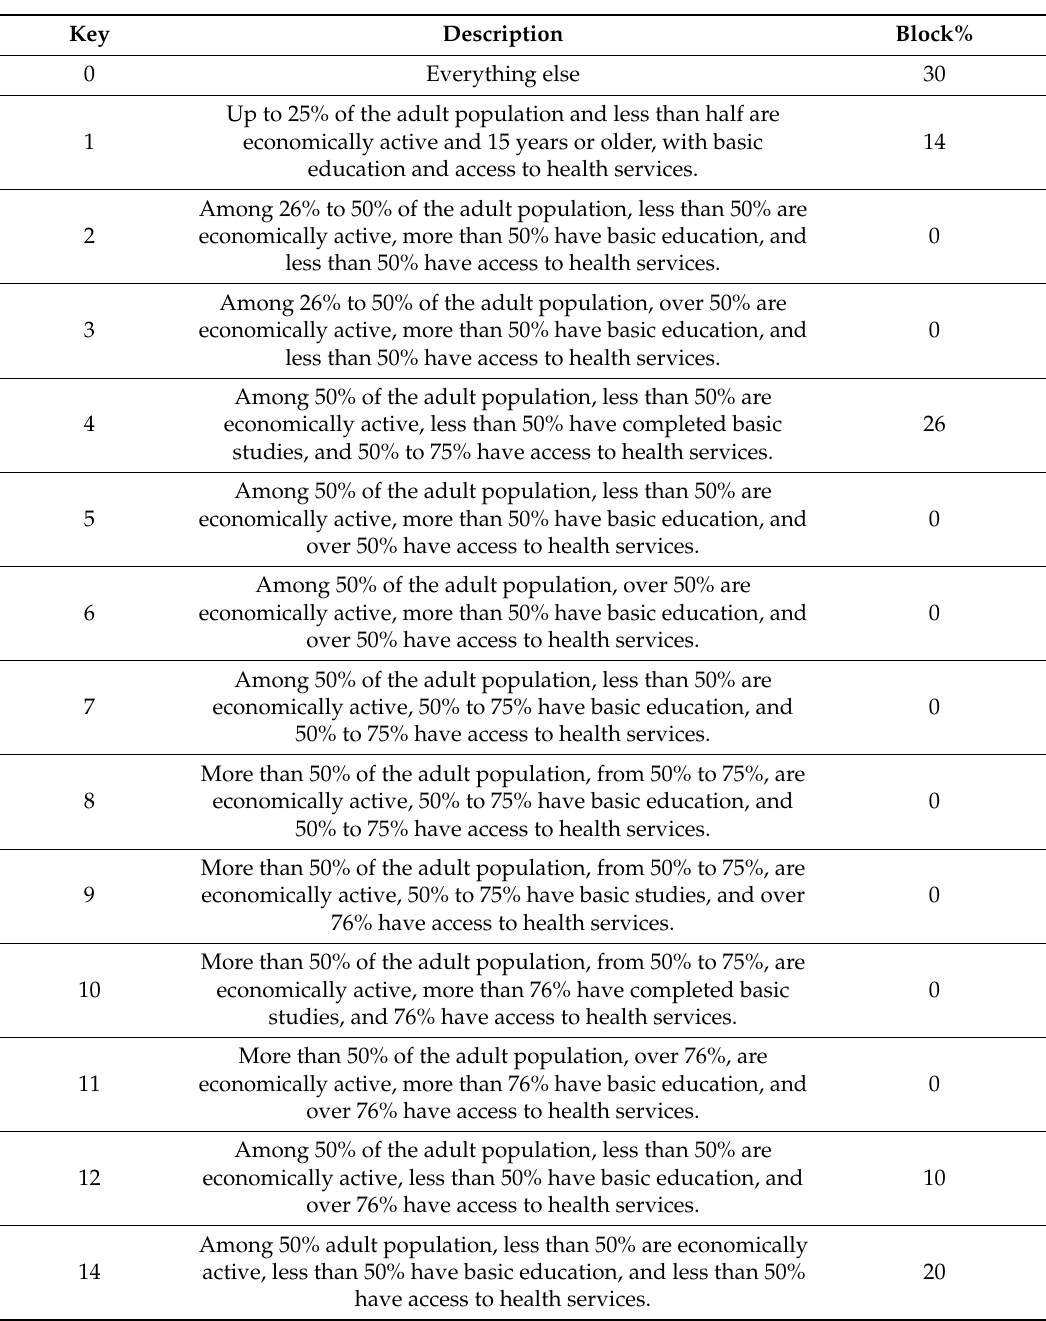
Table 2. The first grouping exercise to determine the clusters of